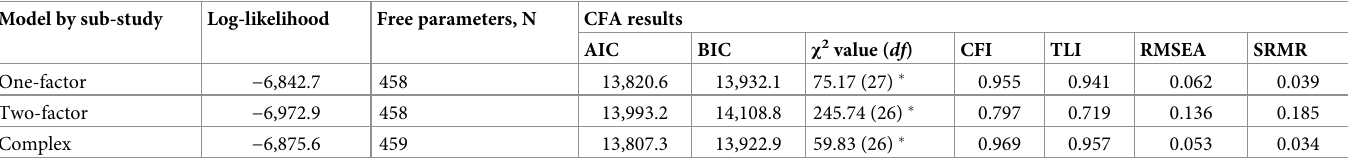
Table 2. Model fit results as revealed by CFA of symptom and function measures. Model by sub-study